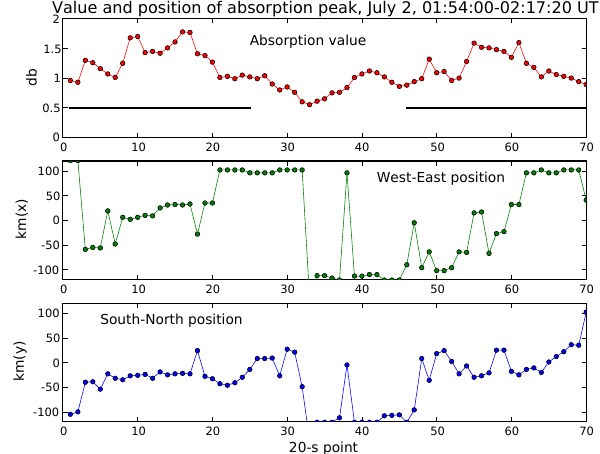
Fig. 13. Magnitude and position of the absorption maximum at 20s interval from 01:54:00 to 02:17:20 UT. The horizontal bars mark the times covered in Figs. 11 and